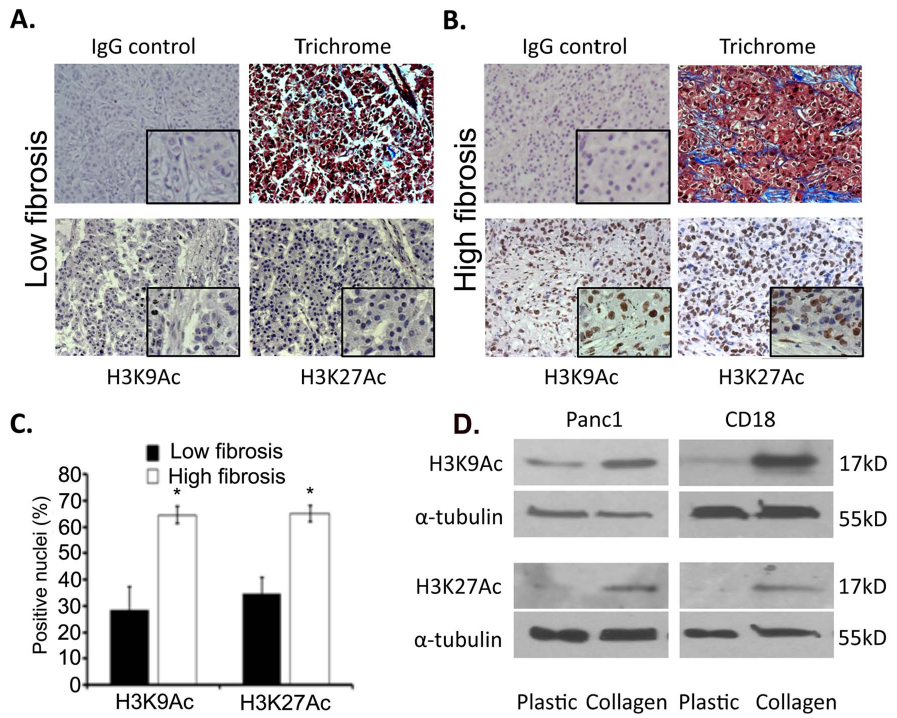
Figure 1. Collagen increases histone H3K9 and H3K27 acetylation. A, B . Human pancreatic tissue microarrays (TMAs) containing 24 specimens were immunostained with IgG control antibody or for histone H3K9 and histone H3K27 acetylation (Ac). The TMAs were also trichrome stained to assess for fibrosis. The insets show higher magnification images of staining with control IgG, and for histone H3K9Ac and histone H3K27Ac. C . Quantification of histone H3K9Ac- and histone H3K27Ac-positive cells was performed using Adobe Photoshop CS3 software. *, p , 0.01 relative to sections with low fibrosis. D . Panc1 and CD18 cells were grown on tissue culture plastic or in three-dimensional collagen gels for 24 hours. Cells were lysed and immunoblotted for histone H3K9Ac and H3K27Ac using a -tubulin as loading control. The results are representative of at least four independent experiments.